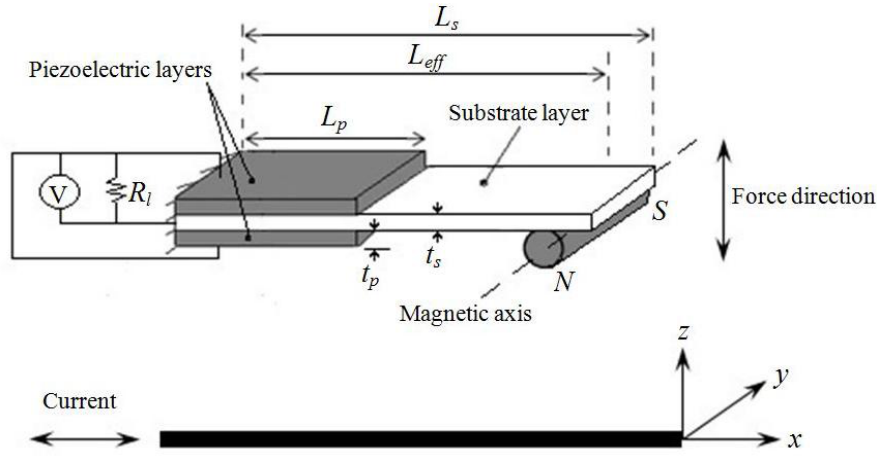
Figure 9. Schematic of the cantilevered beam